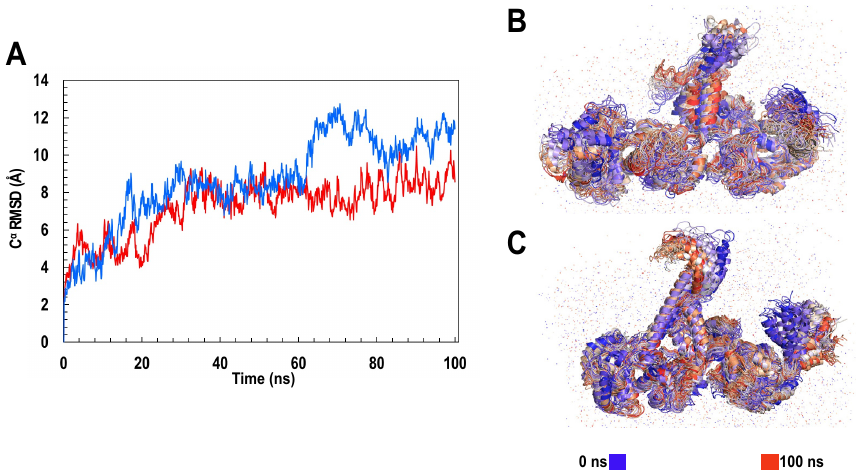
Figure 9. Trajectory analysis showing the RMSD values and the conformational changes of ClpK and ClpB over 100 ns. ( A ) RMSD values of ClpK and ClpB over 100 ns. The trajectory of ClpK is indicated in red and the trajectory of ClpB is indicated in blue. ( B ) Conformational changes of ClpB observed over 100 ns. ( C ) Conformational changes of ClpK observed over 100 ns.